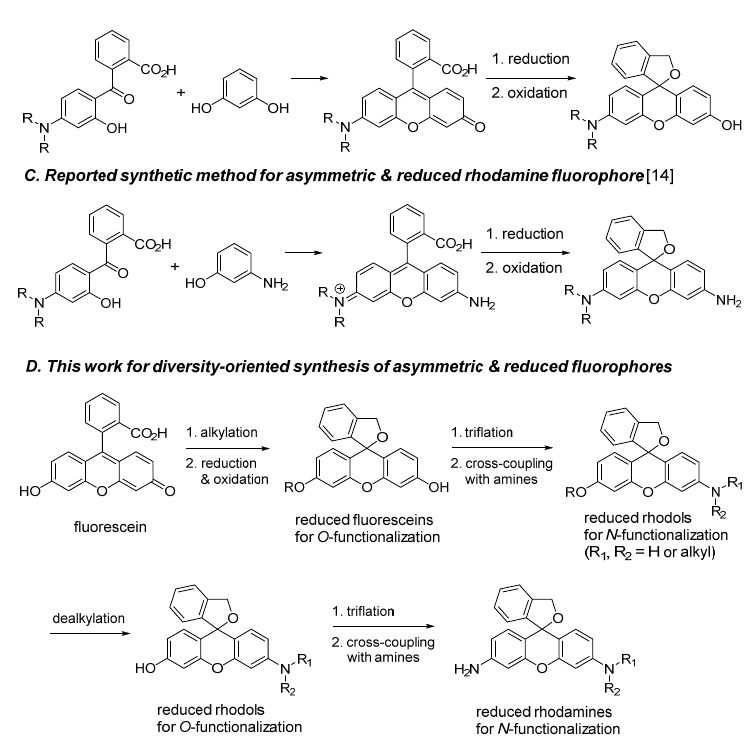
Figure 2. Strategies for synthesizing asymmetric and reduced xanthene fluorophores.